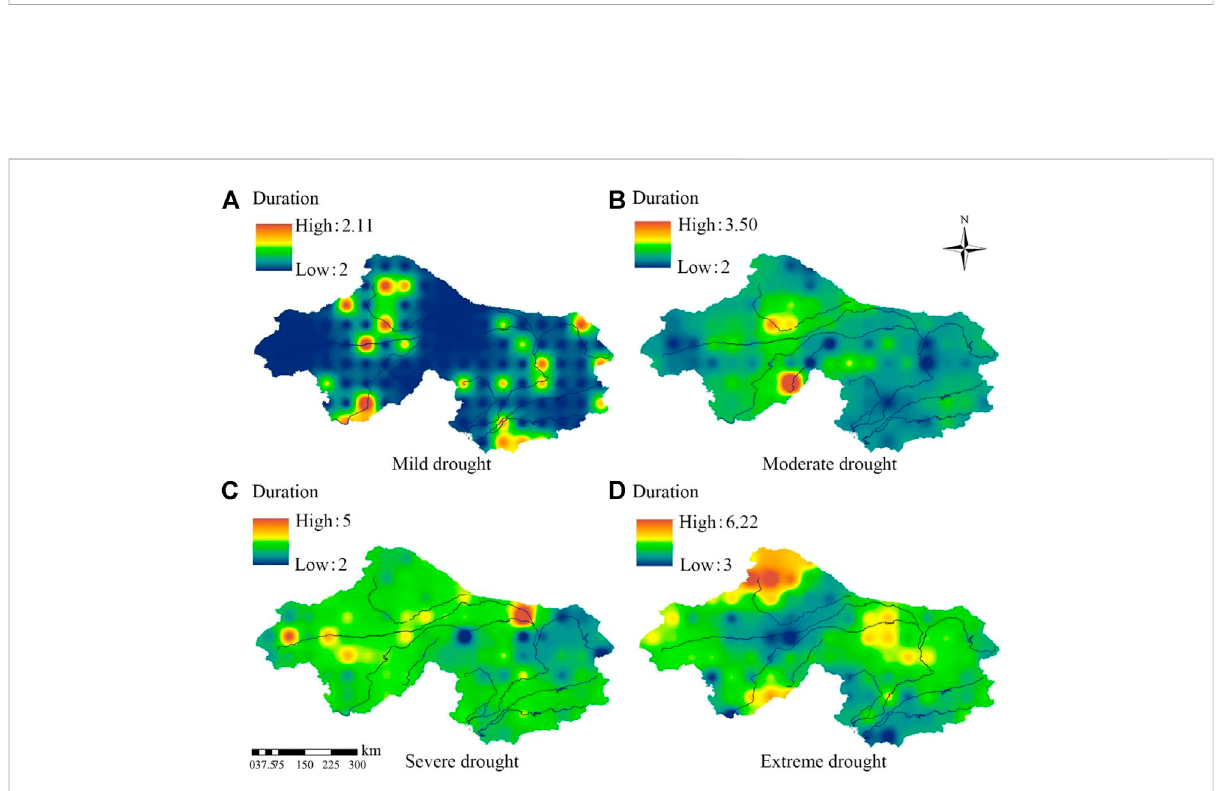
FIGURE 6 Spatial distribution of drought duration at different drought levels from 1961 to 2018. (A) is mild drought, (B) is moderate drought, (C) is severe drought, (D) is extreme drought. (Numerical unit: month).